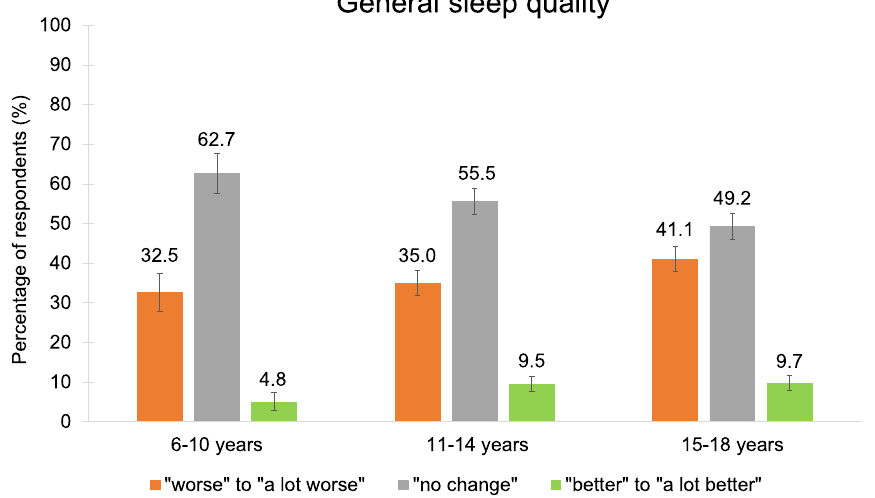
Figure 2. Change in general sleep quality. Around one third of children and adolescents reported to sleep “worse” or “a lot worse” while more than half of the participants experienced “no change” in their quality of sleep compared to before the pandemic.